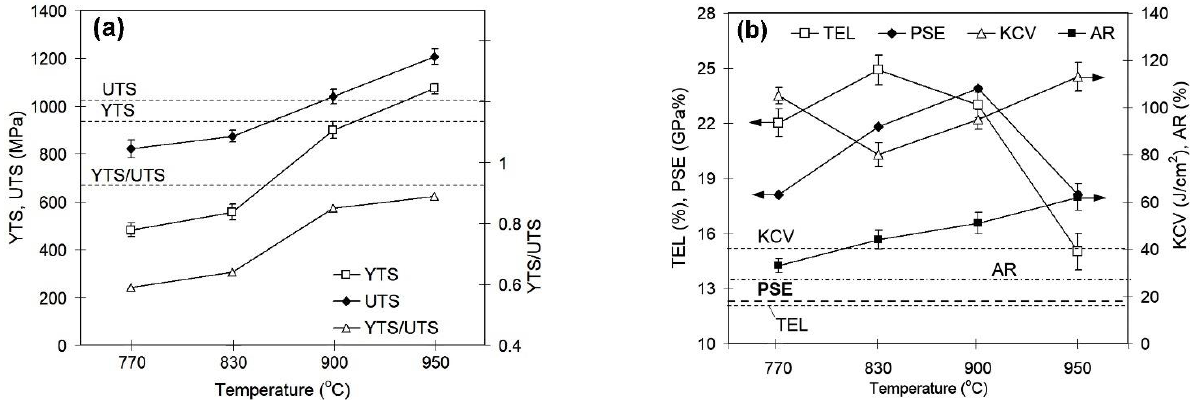
Figure 4. Effect of austenitizing temperature on the mechanical properties of the austempered specimens ( a ) YTS, UTS, YTS/UTS ratio and ( b ) TEL, PSE, KCV, AR. The total elongation (TEL) values varied non-monotonically, with a maximum value (25%) referred to as T A = 830 ◦ C (Figure 4b). TEL decreased to 23% at T A = 900 ◦ C,